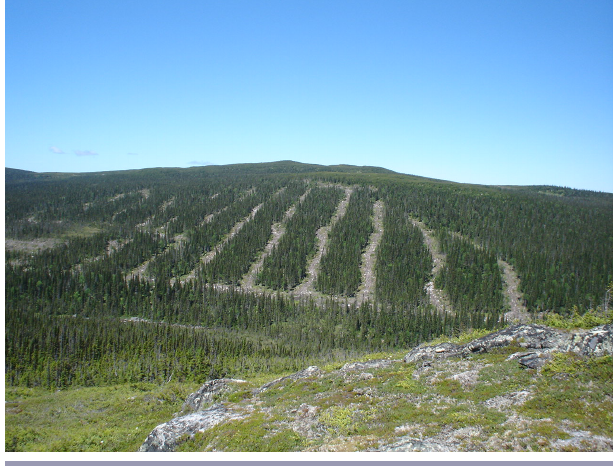
Fig. 3 . A modified harvest block (strip cut) in old growth forest in the northwest portion of the study area. Gray-cheeked Thrushes (Catharus minimus minimus) were observed at three of four survey points in this block. Note that this photo was taken in June 2005, so some additional vegetation growth would have occurred in the strip cuts prior to the initiation of thrush surveys in June 2006. (Photo by D.